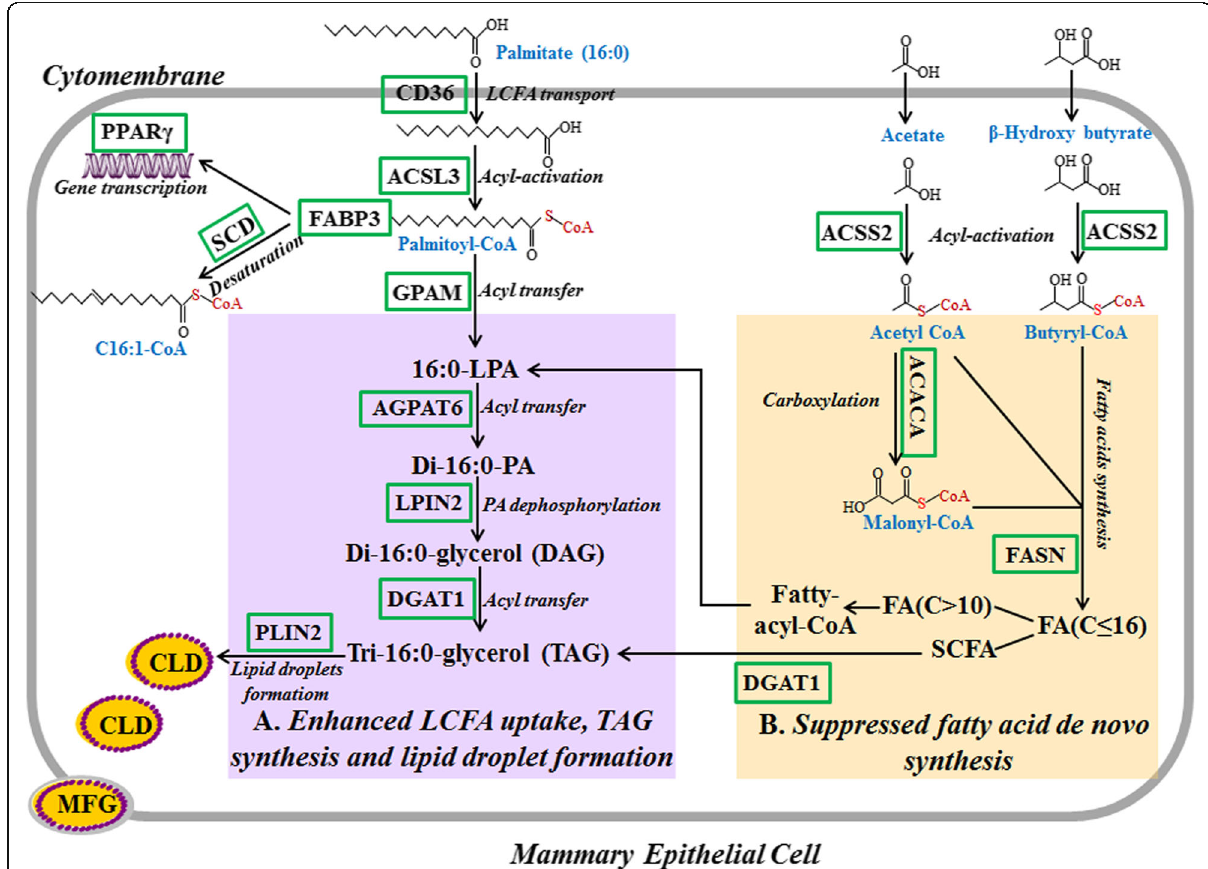
Fig. 5 Scheme summarizing interrelationships among cellular pathways regulating lipid synthesis by palmitate in pMECs. a Palmitate enhanced the uptake of exogenous LCFA, TAG synthesis, and lipid droplet formation. Uptake of LCFA in pMECs, exampled by palmitate (16:0), was enhanced by palmitate through activating transport proteins (mainly CD36). Cytosolic 16:0 is converted into its activated form (16:0-CoA), with the help of ACSL. Cytosolic 16:0-CoA is transported to endoplasmic reticulum membrane by FABP and esterified there to glycerol-3-phosphate to produce 16:0-LPA by GPAM. In endoplasmic reticulum, addition of a second 16:0-CoA produces di-16:0-PA; di-16:0-PA can be hydrolyzed with LPIN to form a di-16:0-glycerol (DAG). The sn-3 position of DAG is then acylated to form TAG by DGAT. Newly formed TAG forms cytoplasmic lipid droplet in the ER membrane via incorporation. Then, the cytoplasmic lipid droplet was transported to the apical membrane and eventually released. b Palmitate suppressed the fatty acid de novo synthesis. In mammary cell, short- and medium-chain fatty acids (almost all C4:0~C14:0 and approximately 50% of palmitic acid) were highly dependent on the de novo synthesis. A series of cytosolic enzymes are required to facilitate this process, of which FASN and ACACA are considered the crucial enzymes of cellular fatty acid de novo synthesis in the porcine mammary gland. ACACA carboxylates acetyl-CoA to form malonyl-CoA, which is further converted by FASN to fatty acids (C ≤ 16). Then, the synthesized fatty acids participate in the TAG formation in endoplasmic